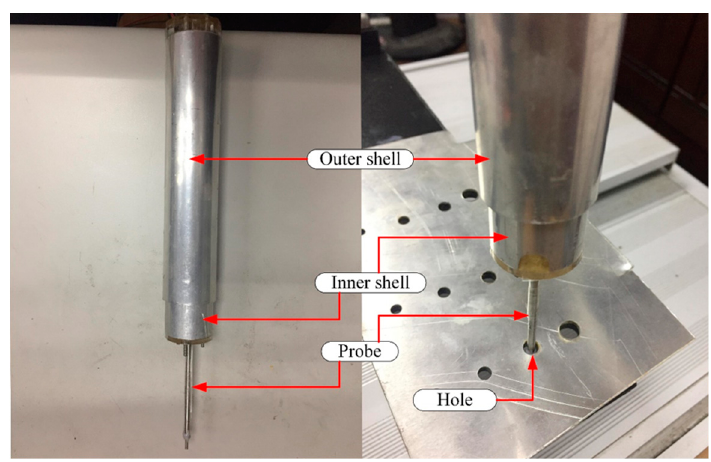
Figure 8. The entity of the device and the state of its measurement.